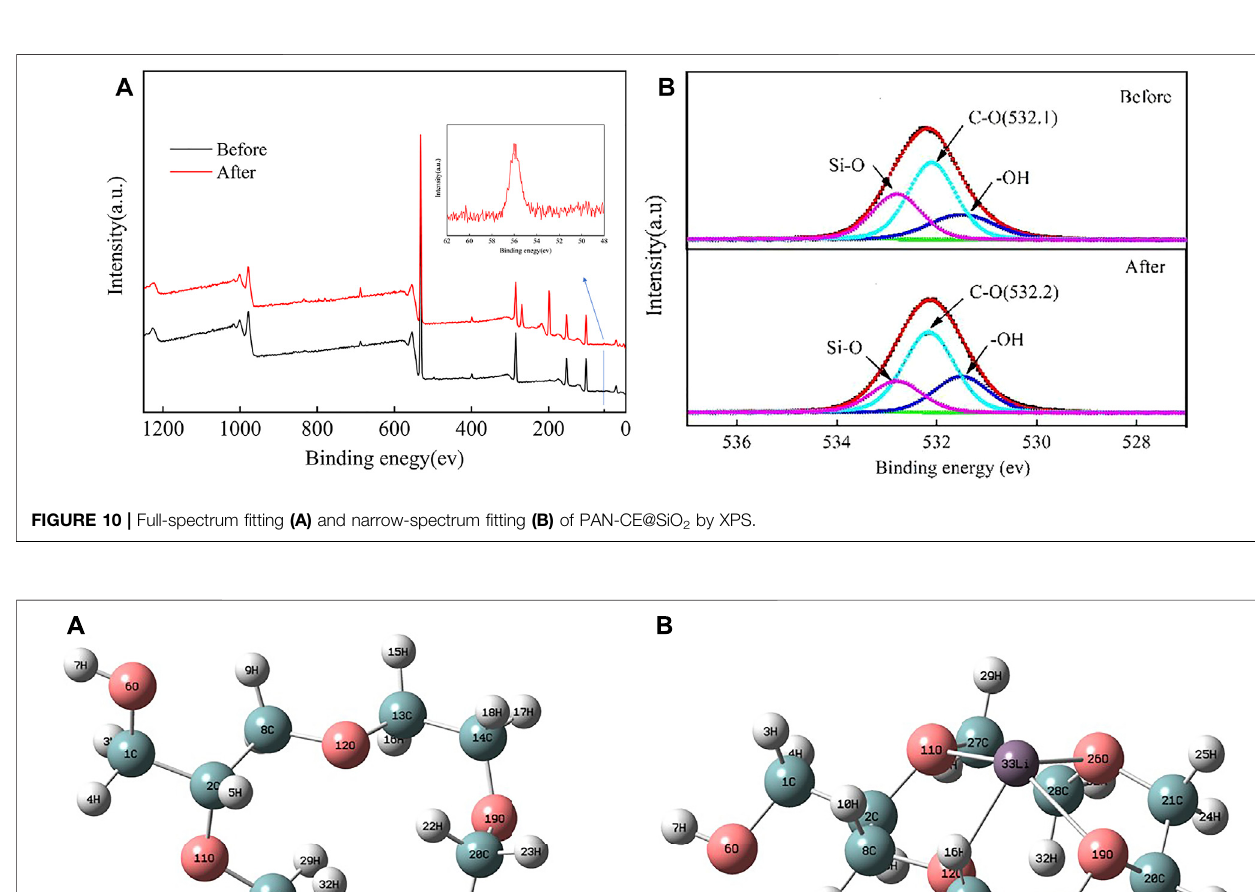
FIGURE 9 | Adsorption mechanisms for Li(I) on the surface of PAN-CE@SiO 2